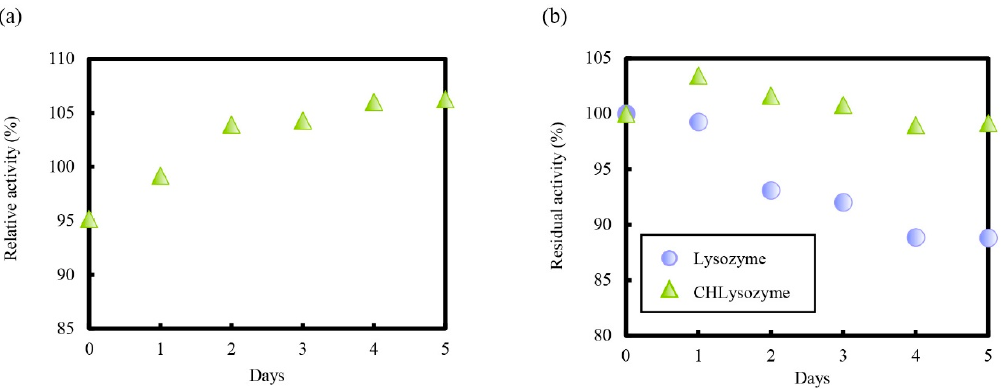
Figure 8. Enzyme activity of CHLysozyme in 0.05 mol / L phosphate bu ff er (pH 6.5) at 25 ◦ C. ( a ) Relative activity of CHLysozyme to lysozyme, ( b ) residual activity of lysozyme and CHLysozyme. Lysozyme and CHLysozyme concentration: 0.2 mg / mL; Micrococcus lysodeikticus concentration: 0.16 mg /